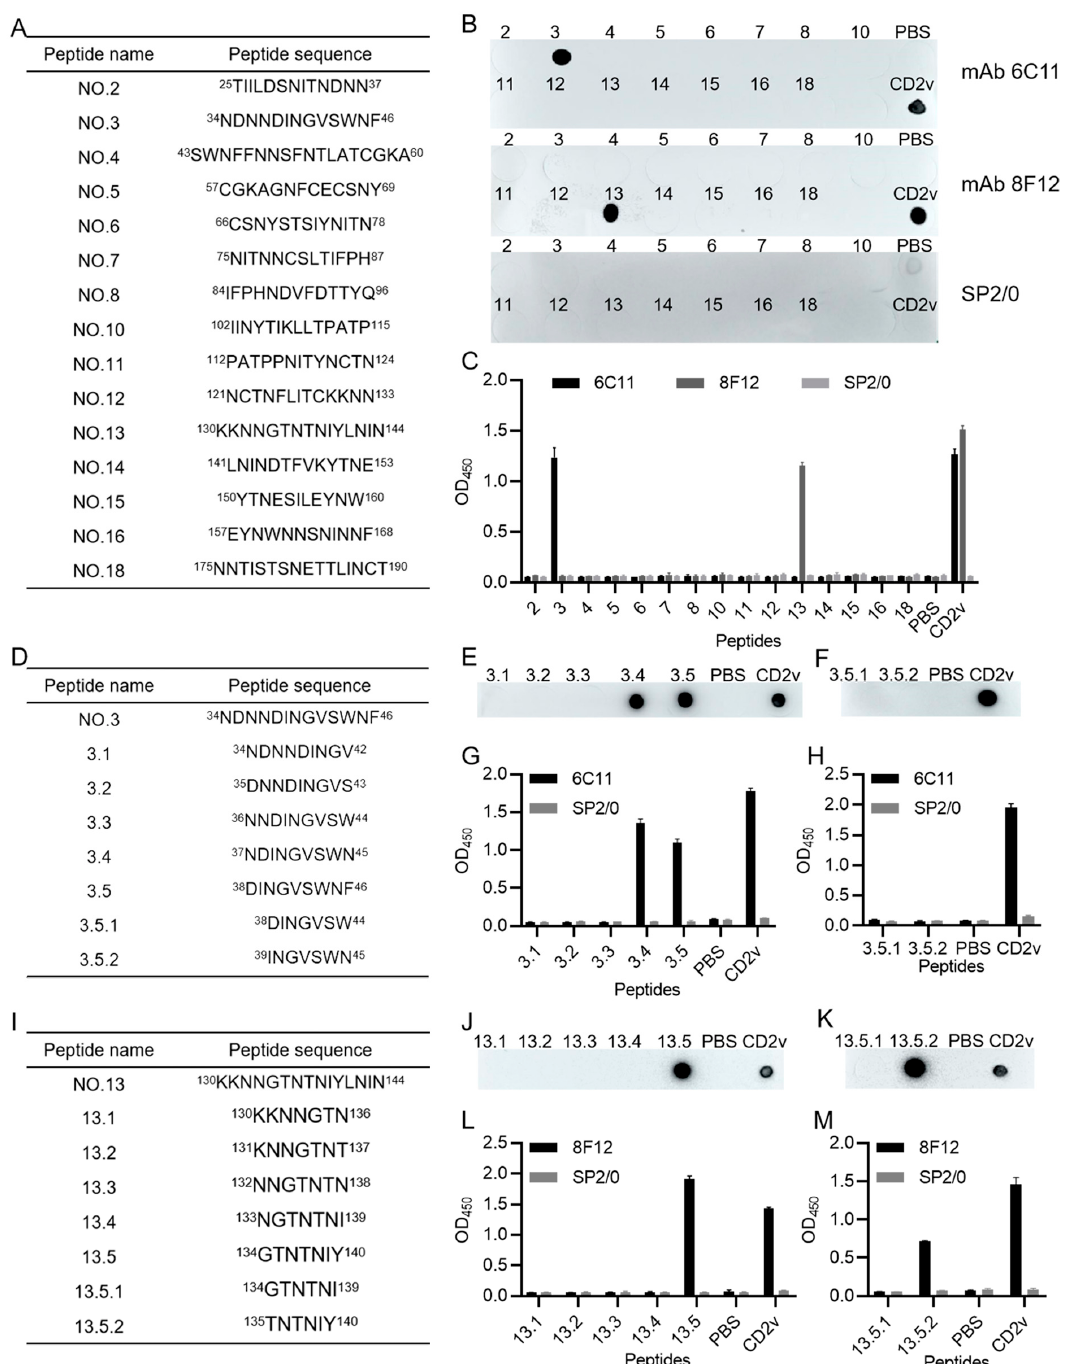
Figure 4. Identification of the epitopes recognized by mAbs 6C11 and 8F12. ( A ) Fifteen synthetic overlap ping peptides spanning the CD2v protein. ( B , C ) Dot blotting and indirect ELISA analysis of mAbs 6C11 and 8F12 against the fifteen peptides. SP2/0 cell supernatants were used as negative control. ( D ) Seven shorter overlapping peptides spanning peptide No.3: 34 NDNNDINGVSWNF 46 . ( E – H ) Dot blotting and indirect ELISA analysis of mAb 6C11 against the seven shorter peptides from peptide No.3. ( I ) Seven shorter overlapping peptides spanning peptide No.13: 130 KKNNGTNTNIYLNIN 144 . ( J – M ) Dot blotting and indirect ELISA analysis of mAb 8F12 against the seven shorter peptides from peptide No.13. PBS and purified CD2v protein were set used as negative and positive controls, respectively.